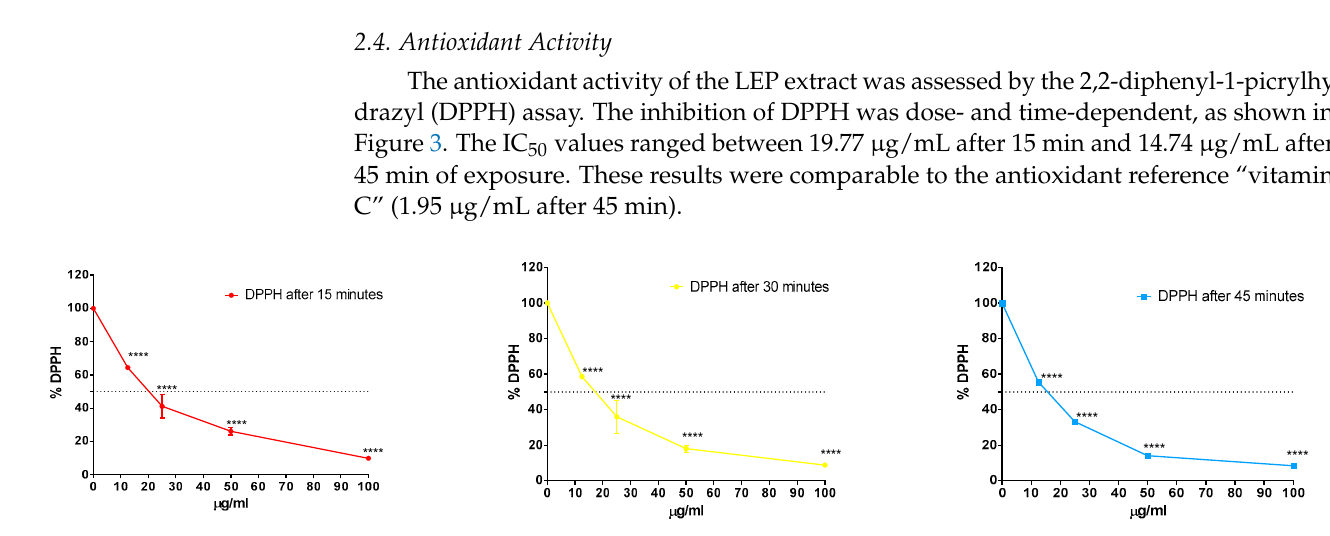
Figure 3. Antioxidant activity of the LEP extract. Values represent the percent of 2,2-diphenyl-1-picrylhydrazyl (DPPH) remaining after 15, 30 and 45 min. **** Values are significantly different at p < 0.0001, according to a two-way ANOVA combined with Tukey’s post-hoc test. Data are expressed as the mean of three replicates ± SD.